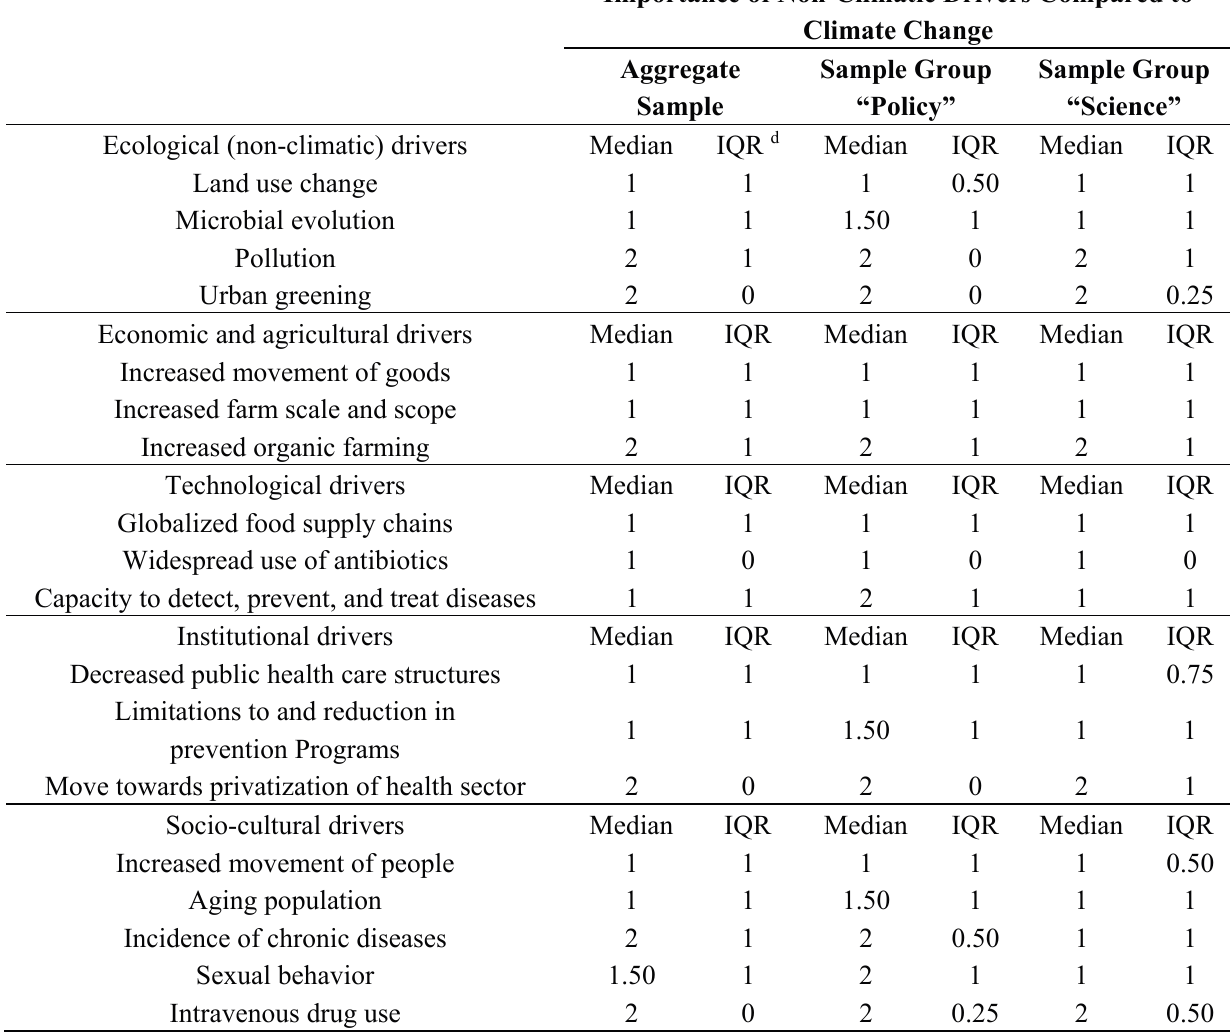
Table 4. Assessment results of the relative importance of each non-climatic driver compared to climate change as a driver of infectious disease risk, for the aggregate sample and for the two sample groups “Policy” and